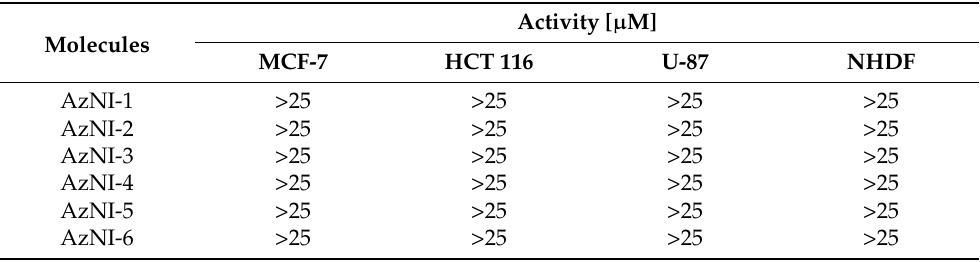
Table 5. Cytotoxicity of the tested compounds on a panel of three human cancer cell lines and normal human